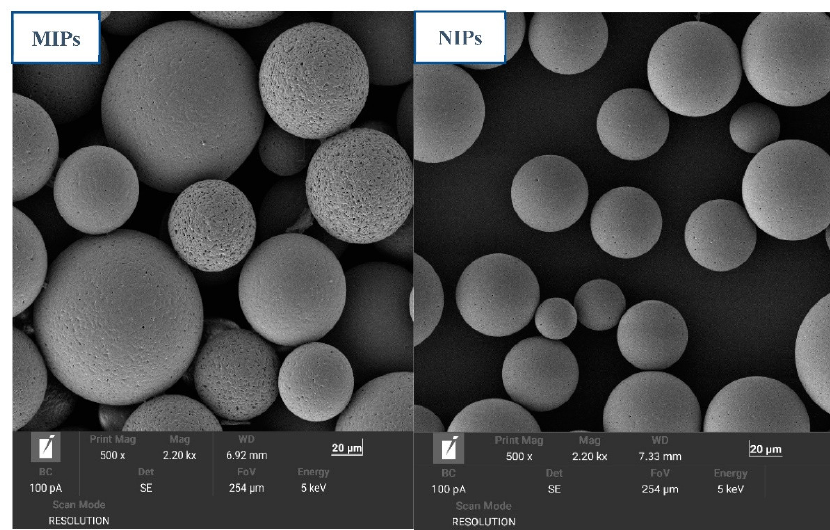
Figure 8. SEM images of the MIP ( left ) and NIP ( right ) microspheres.